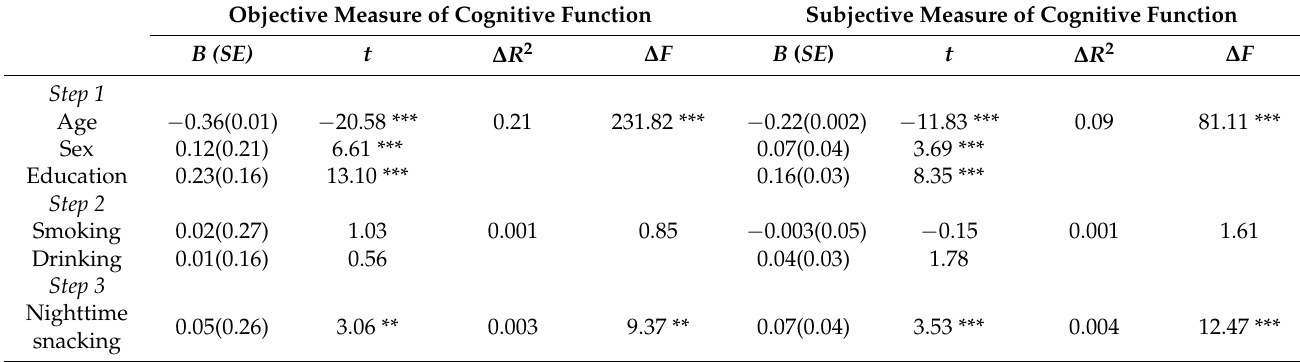
Table 2. Hierarchical regression analysis of nighttime snacking on cognitive function ( n =